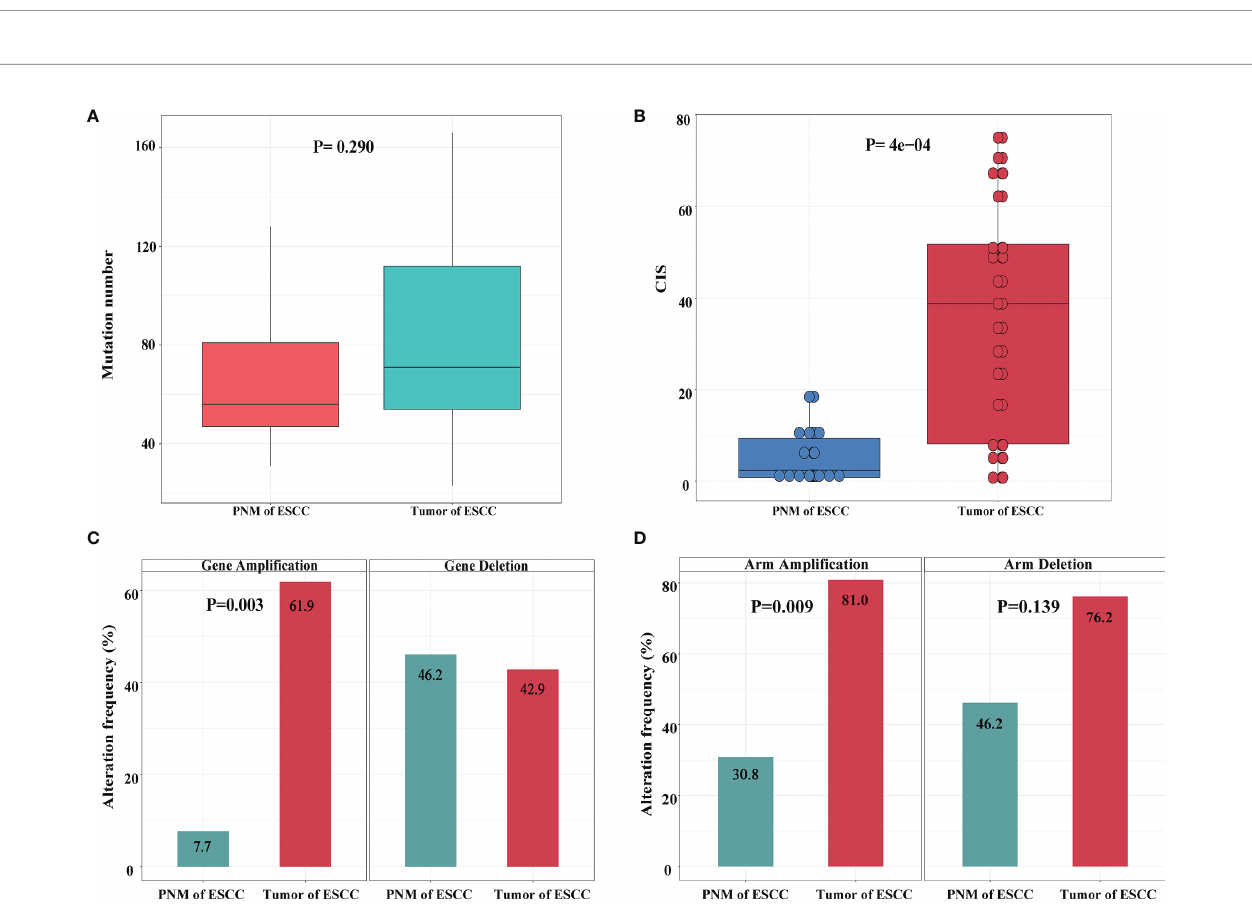
FIGURE 3 | Summary of genomic variations in the ESCC samples. (A) Comparison of mutation numbers per sample in ESCC PNM and tumor. (B) Comparison of CIS between ESCC PNM and tumor samples. Comparisons of (C) gene level and (D) chromosomal arm level copy number ampli fi cation (left) and deletion (right) between ESCC PNM and tumor